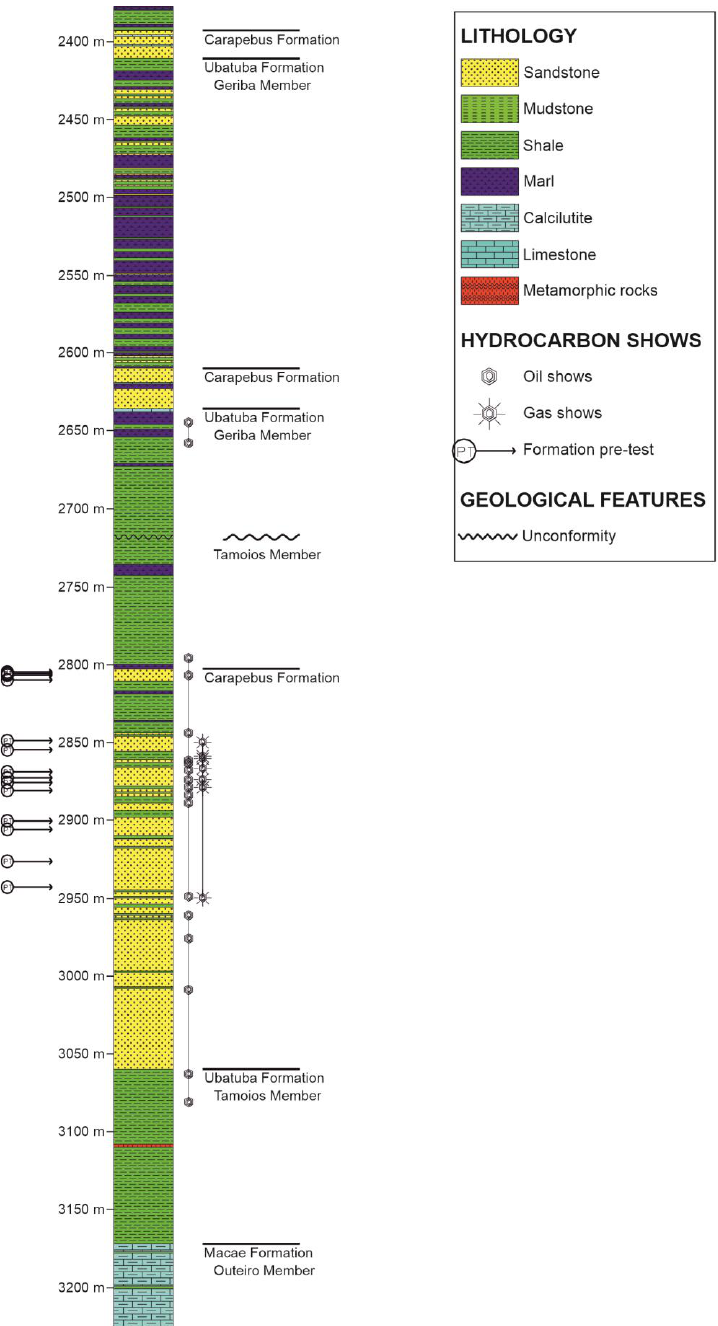
Figure 11. The 835 m interval of the composite profile of exploratory well 3-RO-4-RJS, from depth of 2395 m to 3230 m (end of well). The occurrence of two intervals of Cretaceous turbidite sandstones of the Carapebus Formation was observed, at the following depths and thicknesses: from 2607 m to 2633 m (26 m thick) and from 2800 m to 3057 m (257 m thick). Several formation pre-tests (with the acronym PT in the profile) were carried out at different depths of the deepest interval of the Carapebus Formation, proving the effectiveness of this formation as a producer of oil and gas. Thick packs of shales of the Ubatuba Formation could be seen over the turbidite sandstones, sealing these reservoirs. This well did not reach the generating shales of the Lagoa Feia Formation, adapted from Ref.